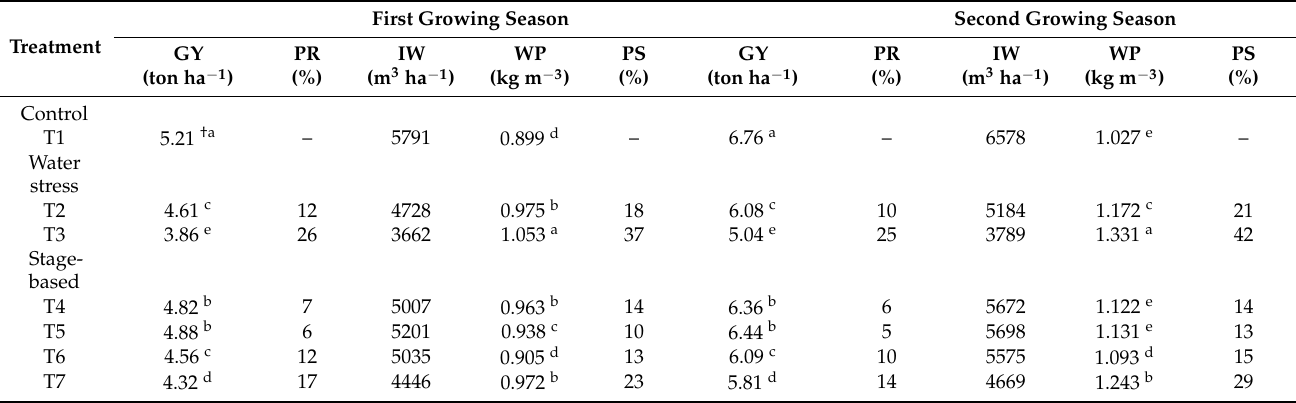
Table 5. The percentage of reduction (PR%) in wheat grain yield (GY), irrigation water applied (IW), water productivity (WP), and percentage of irrigation water saving (PS%) as a result of the irrigation treatments application.